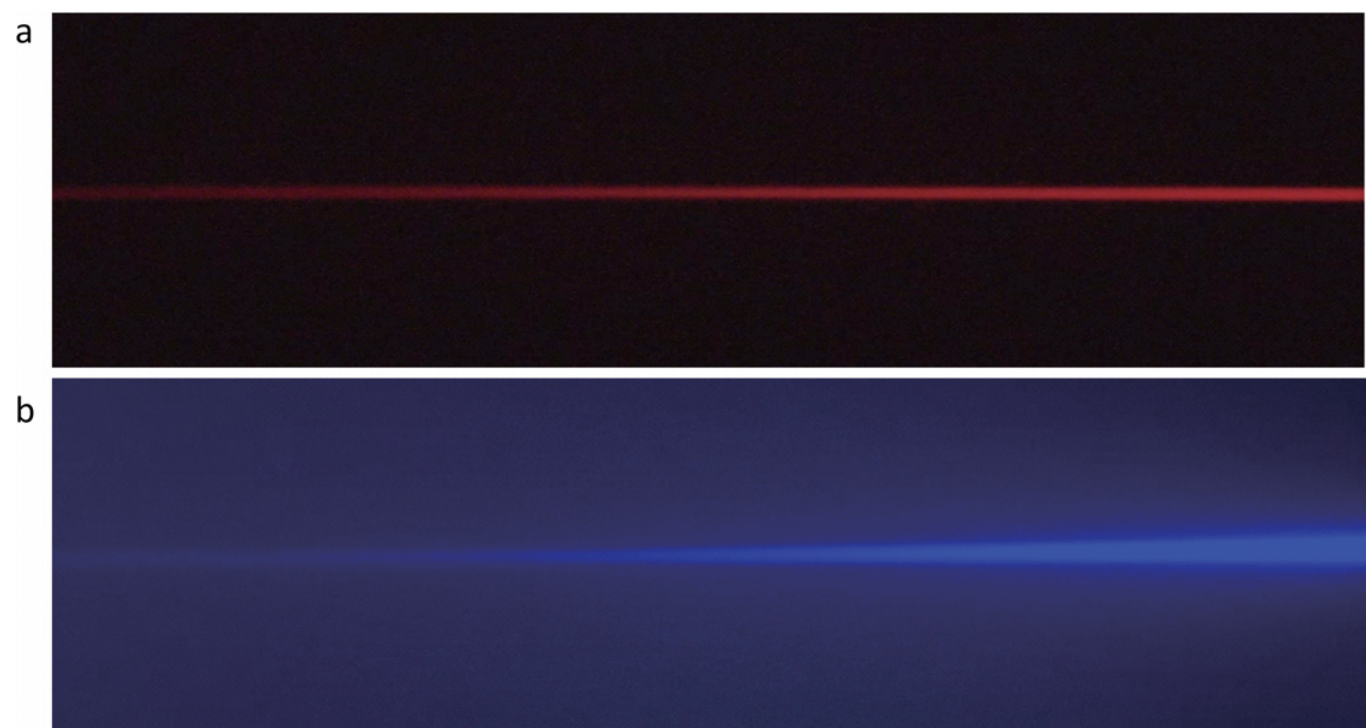
Fig 3. Rayleigh scattering phenomenon. a. The red light passes through the skim milk in a glass. b. The blue light scatters and little of it passes through the skim milk in a glass.